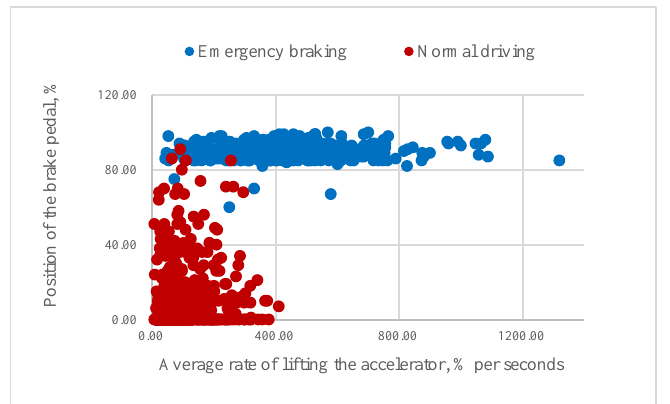
Figure 8. Relationship between the average rate of lifting the accelerator and the position of the pressed brake pedal. Algorithms 2017 , 10 , 129